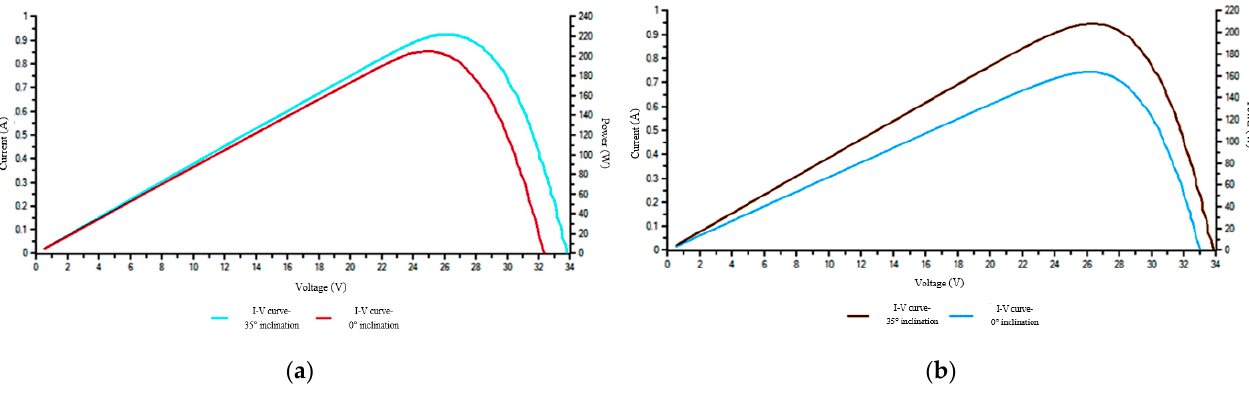
Figure 13. Power – Voltage diagram of tilted and horizontal PV panels. ( a ) summer, ( b ) winter. Figure 13. Power–Voltage diagram of tilted and horizontal PV panels. ( a ) summer, ( b )